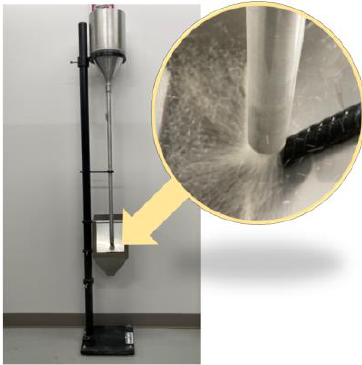
Figure 2. Setup of falling sand abrasion test.